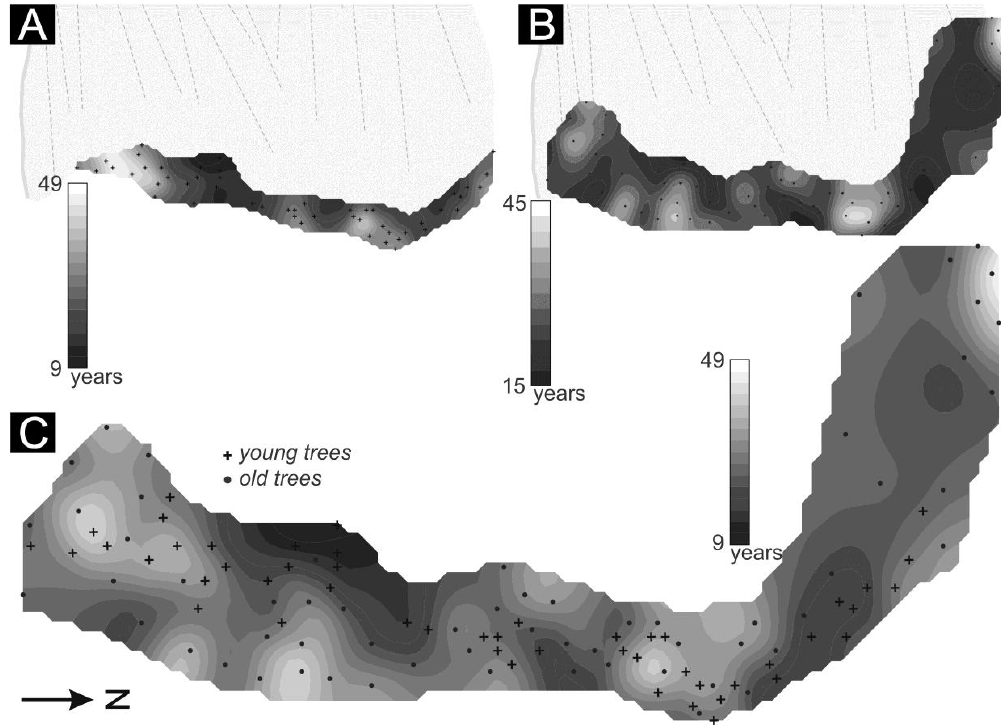
Fig. 6. Spatial distribution of recurrence intervals ( R i ). A – young trees, B – old trees, and C – all Figure 6: Spatial distribution of recurrence intervals (R all trees. 555